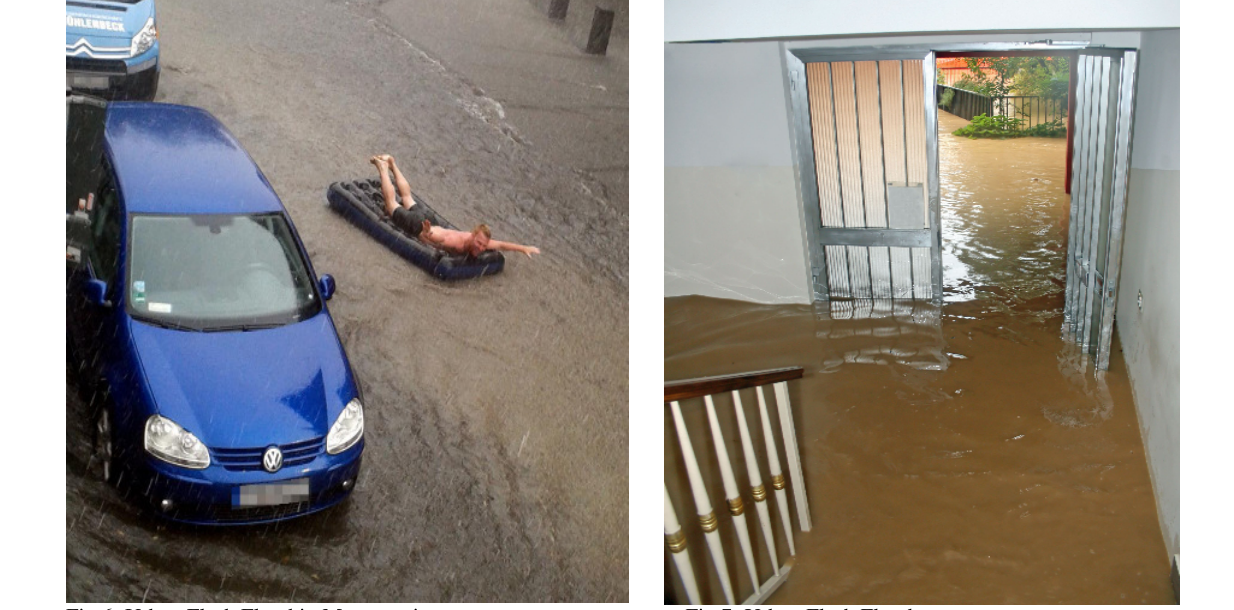
Fig 6: Urban Flash Flood in Münster city Fig 7: Urban Flash Flood, (Source: dpa/cas fdt) Water in a private